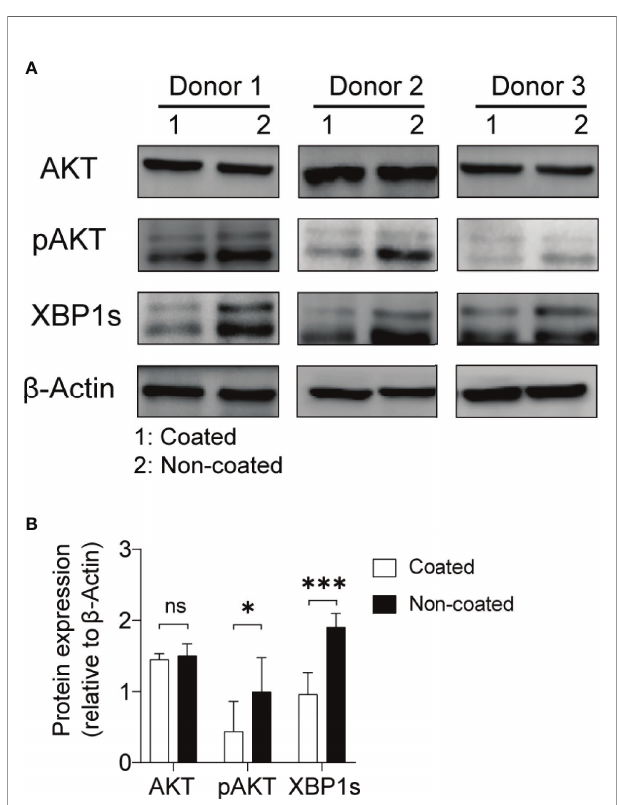
FIGURE 8 | NK cells expanded with non-coated rituximab had higher levels of p-AKT and XBP-1s. After expansion for 14 d, NK cell proteins were extracted and assayed by western blotting. (A) Western blots for AKT, p-AKT, and XBP1s in NK cells from three donors activated with coated or non-coated rituximab. (B) Densitometric quanti fi cation showing the ratios of AKT, p-AKT, and XBP1s to b -actin. n = 3 donors, ns, not signi fi cant p > 0.05, * p < 0.05, *** p < 0.001; two-tailed paired